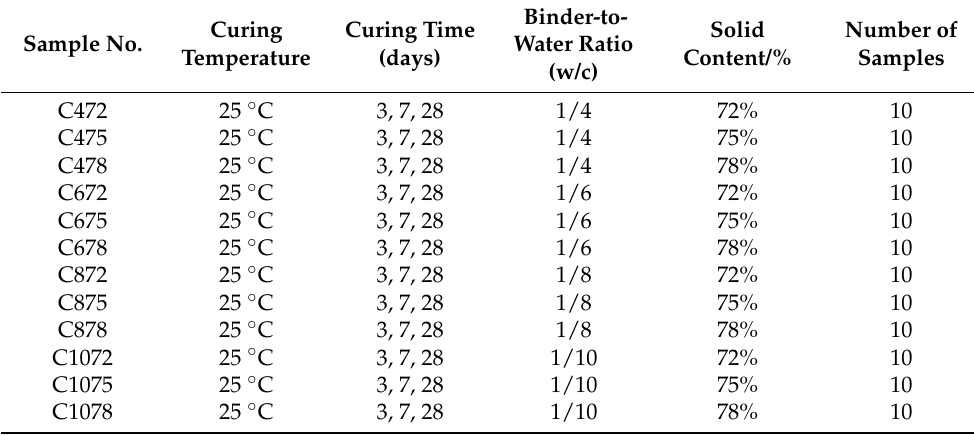
Table 4. The paste proportions for tests.